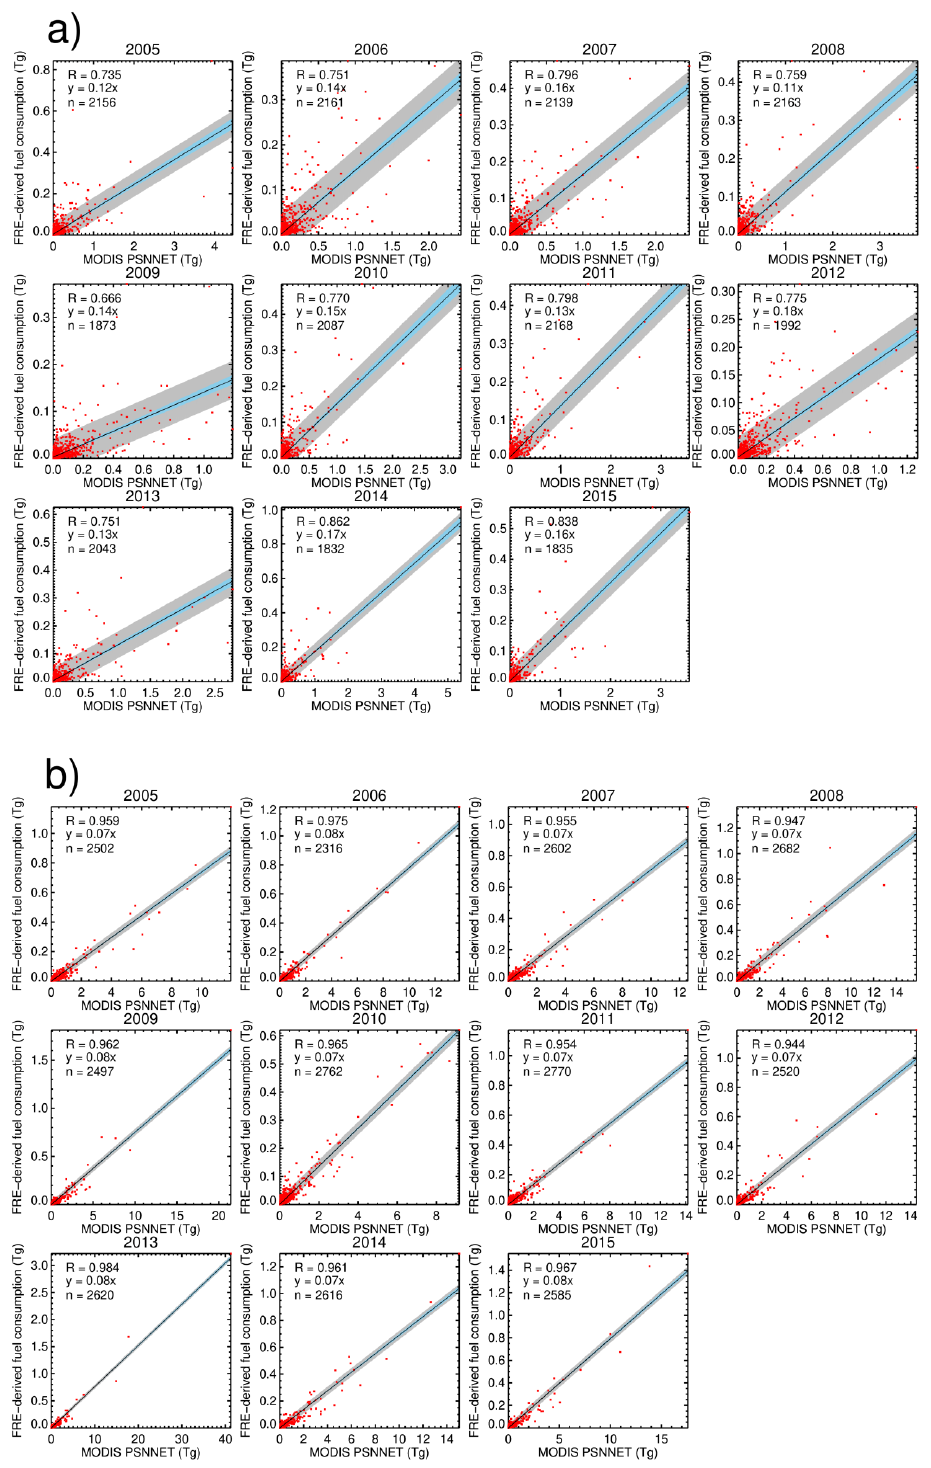
Figure 6. The relationship between FRE-derived fuel consumption (Tg DM) and accumulated PSN (Tg) per-fire cluster basis for the northern ( a ) and southern ( b ) hemisphere Africa between 2005 and 2015. The grey shaded area represents the prediction interval and the blue shaded area is the slopes 95% confidence interval. Note that the x - and y -axis range differs among